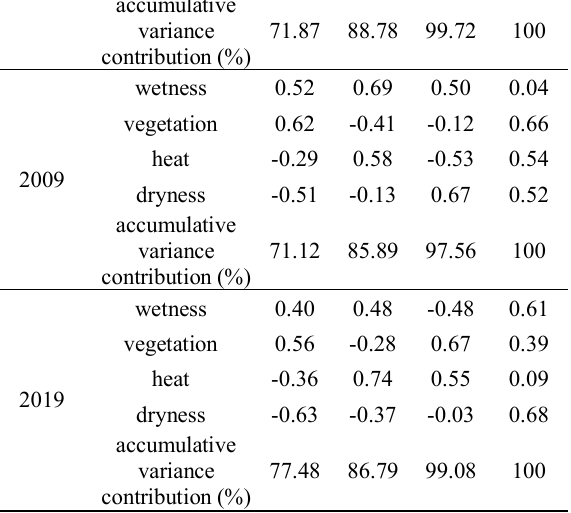
Table 2. Results of PCA analysis